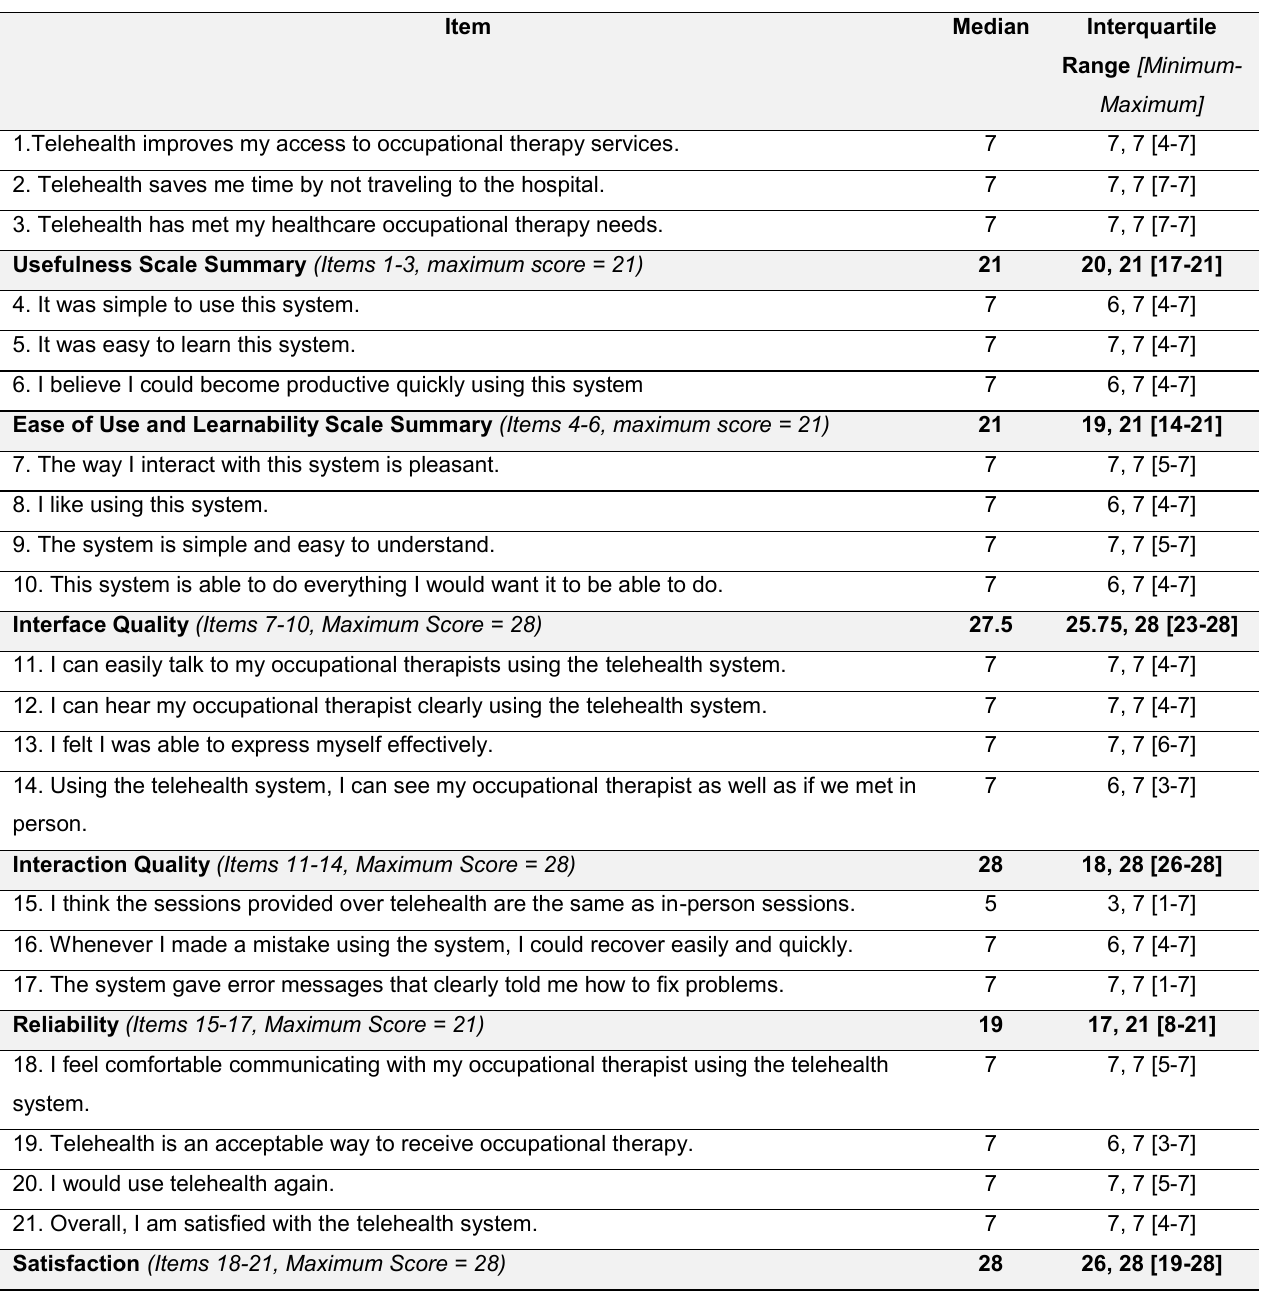
Telehealth Usability Questionnaire (TUQ) Results for the Case Group (n=51)